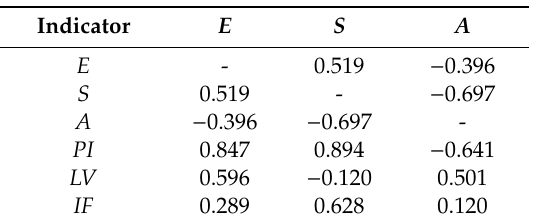
Figure 3. Box and whisker diagrams for data distribution characteristics of primary components (exposure 𝐸, sensitivity 𝑆, and lack of adaptability 𝐴 ), and intermediate components (potential (exposure E , sensitivity S , and lack of adaptability A ), and intermediate components (potential impact impact 𝑃𝐼 , livelihood vulnerability 𝐿𝑉 , and internal factor 𝐼𝐹 ) for the study site. PI , livelihood vulnerability LV , and internal factor IF ) for the study site. Table 2. The comparison of relationships between primary components (exposure 𝐸, sensitivity 𝑆, Table 2. The comparison of relationships between primary components (exposure E , sensitivity S , and and lack of adaptability 𝐴 ), and relationships of each primary component to intermediate lack of adaptability A ), and relationships of each primary component to intermediate components components (potential impact 𝑃𝐼 , livelihood vulnerability 𝐿𝑉 , and internal factor 𝐼𝐹 ), measured by (potential impact PI , livelihood vulnerability LV , and internal factor IF ), measured by the coe ffi cient the coefficient of correlation. of